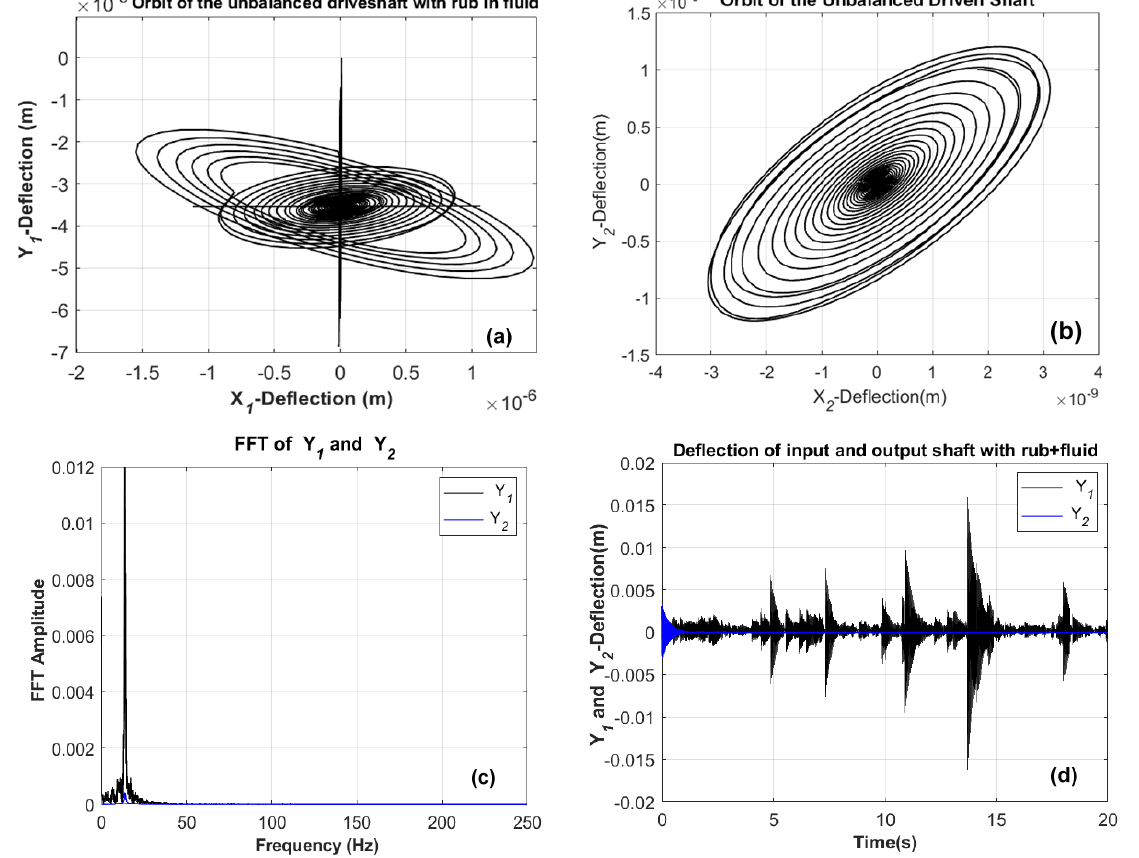
Figure 12. Dynamic response of driveline rotors with driveshaft-to-stator rubbing inside fluid ( a ), ( b ) orbit of the input and output shafts, ( c ) Fast Fourier Transform spectrum response ( d ) transient deflection response of shafts.